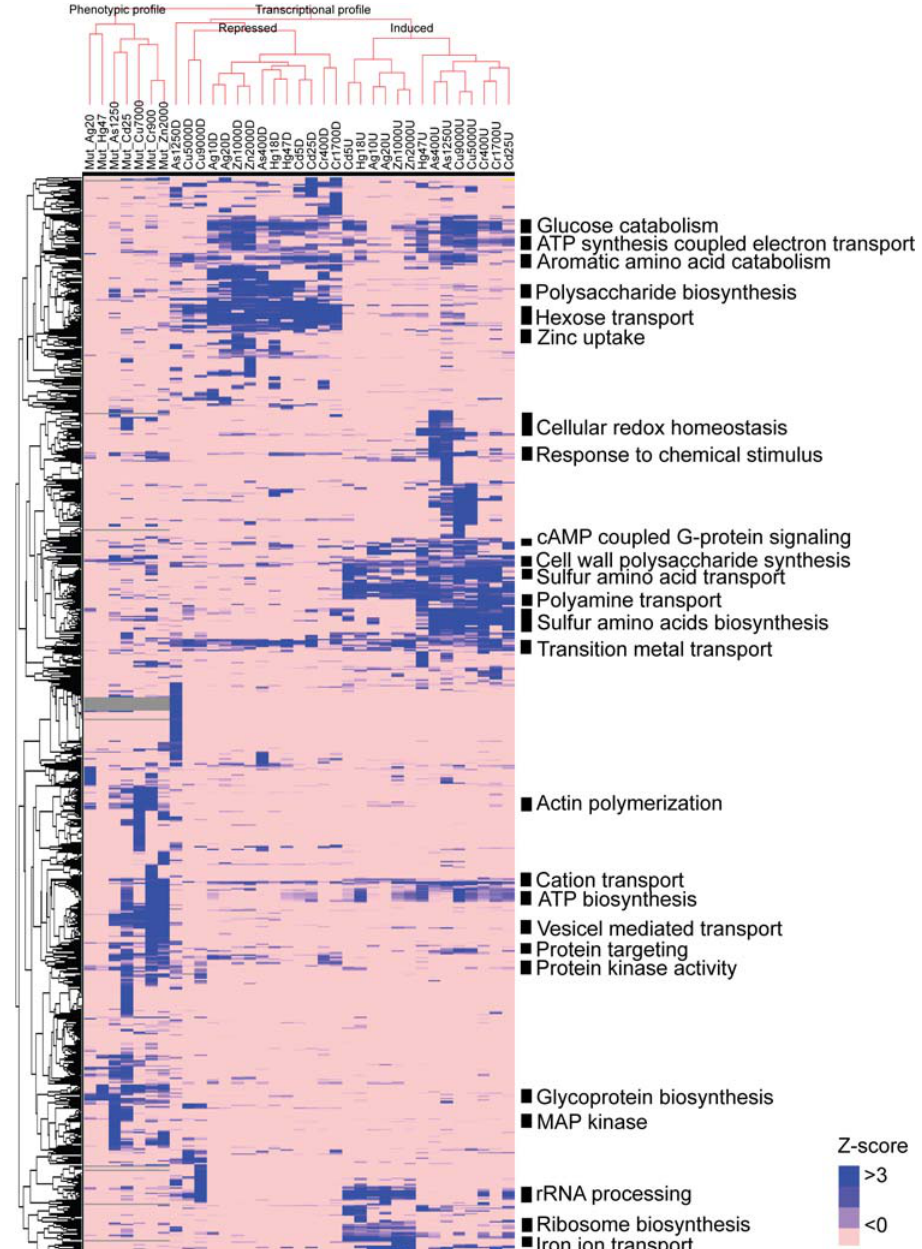
Figure 5. Two dimensional hierarchical clustering of transcriptome and deletome Gene Ontology terms. Clustering of the data is as described in the legend to Figure 3. Metal species and concentrations ( m M) are indicated at the top of each column. Labels with the Mut prefix indicate deletome data. Labels containing a U or D suffix indicate transcriptome data for genes whose level of expression increased or decreased in response to metal exposure, respectively. The Gene Ontology Z-score data presented in this Figure can be found in Table